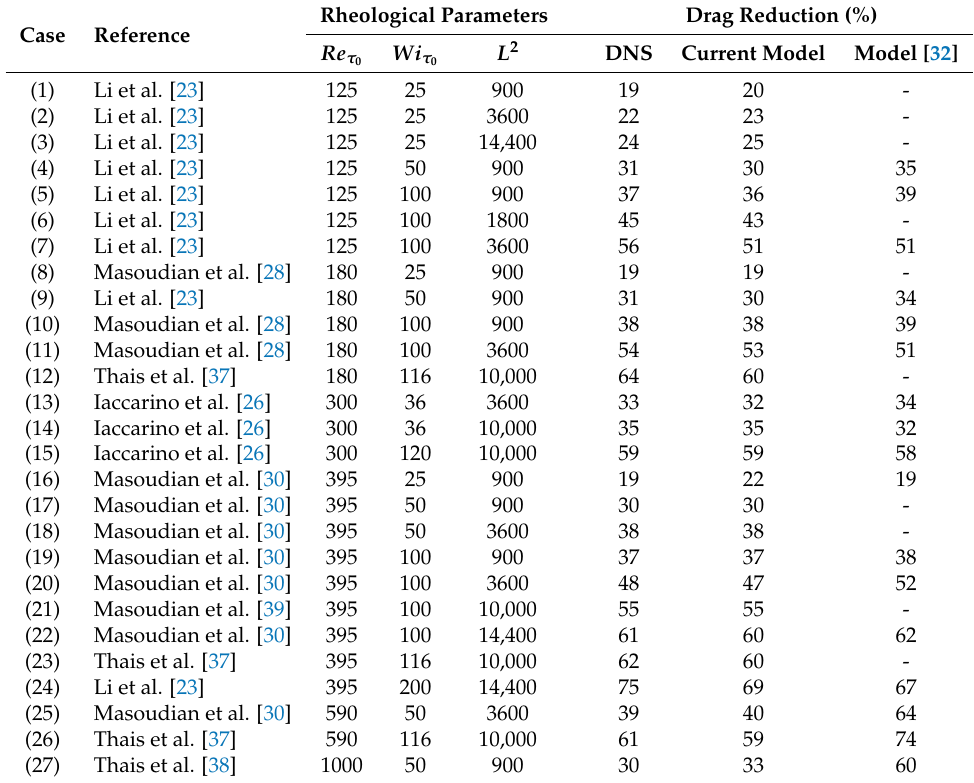
Table 1. Independent Direct Numerical Simulation data for turbulent channel flow of finitely extensible nonlinear elastic-Peterlin (FENE-P) fluids at β = 0.9, with drag reduction (DR) model predictions.